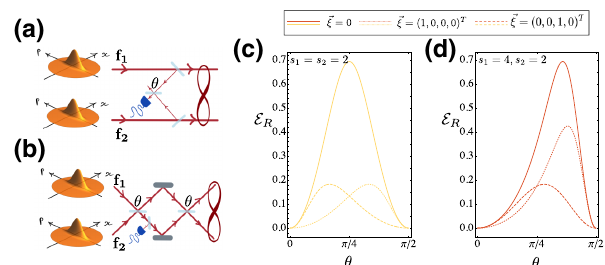
FIG. 7. Entanglement creation through photon subtraction in a superposition of uncorrelated modes f 1 and f 2 . (a),(b) Sketches of two equivalent setups to implement a photon subtraction in (cid:13) (cid:13) (cid:13) the mode b , with f 2 . In (c),(d), we show the b = cos θ f 1 + sin θ created entanglement, as measure through the Rényi entropy, Eq. (256), for varying values of θ . The initial Gaussian states are = diag[ s / s = pure, with covariance matrices V f 1 , 1 1 ] and V f 2 1 diag[ s 2 , 1 / s 2 ] for modes f 1 and f 2 , respectively. The global mean field, i.e., displacement, is varied (cid:13) ξ = 0 (solid curves), (cid:13) ξ = ( 1, 0, 0, 0 ) T (dotted curves), and (cid:13) ξ = ( 0, 0, 1, 0 ) T (dotted curves). (c) The particular case where the squeezing is balanced, i.e., s 1 = s 2 = 2. (d) An unbalanced example where s 1 = 4 and s 2 = 2. All squeezing values s 1 and s 2 are measured in units of vacuum